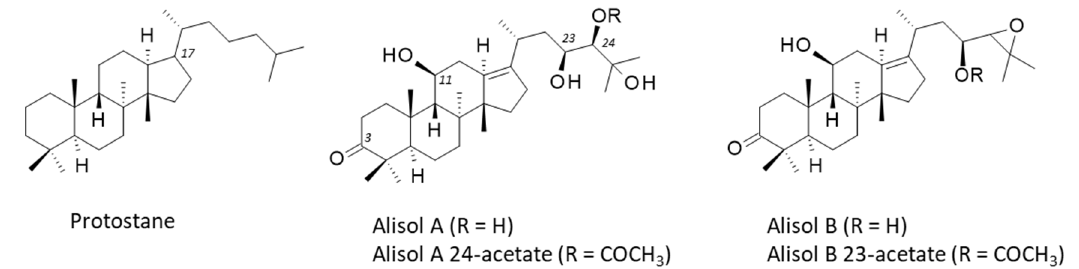
Figure 2. Structures of the protostane terpenoid skeleton and the main alisol compounds, Ali-A/-B and their acetate derivatives. The numbering of specific positions (discussed in the text) is indicated.